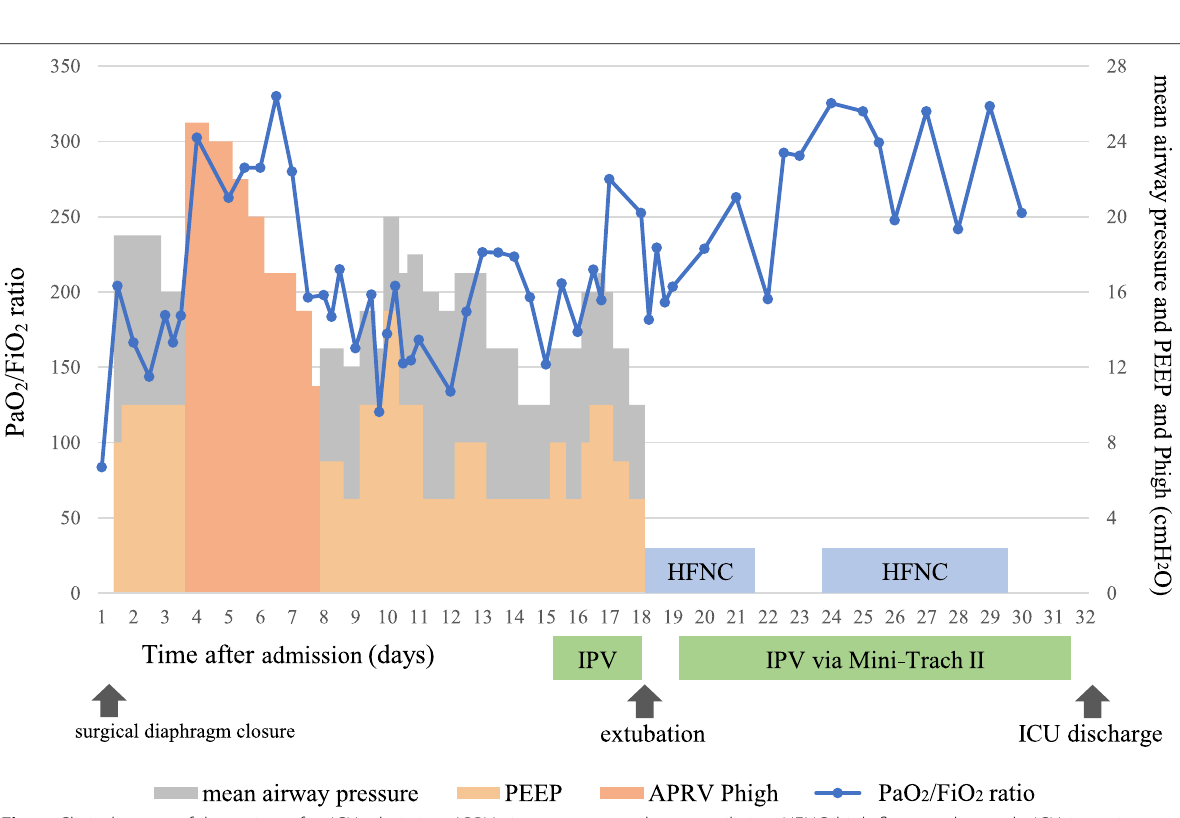
Fig. 4 Clinical course of the patient after ICU admission. APRV, airway pressure release ventilation; HFNC, high-flow nasal cannula; ICU, intensive care unit; IPV, intrapulmonary percussive ventilation;